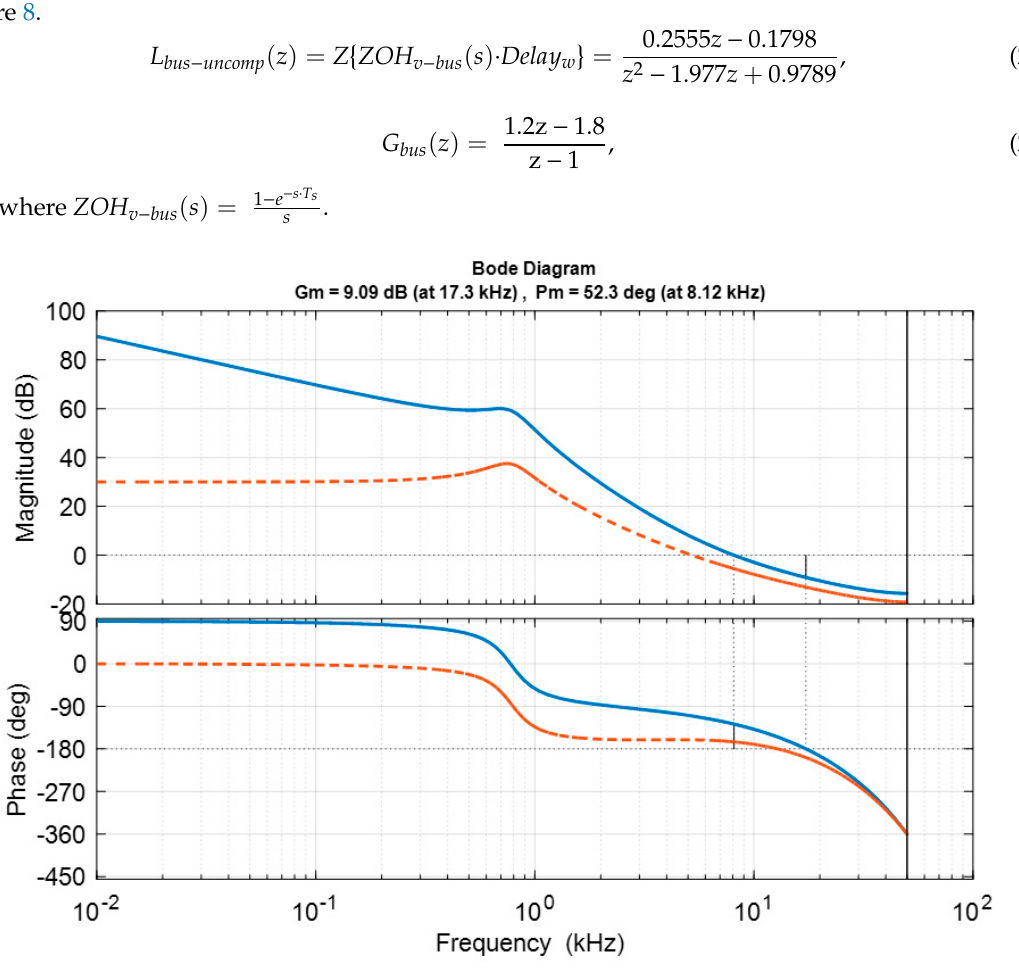
Figure 8. The bode plot of the uncompensated (red-dashed curve) and compensated (blue-solid curve) bus voltage control loop gain.